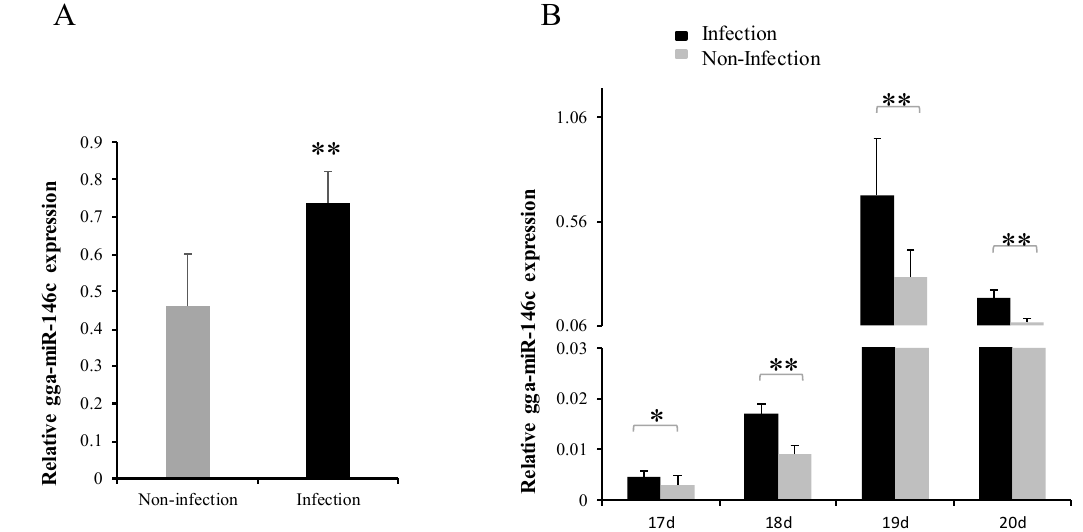
Figure 1. Mycoplasma gallisepticum ( MG) infection generated gga-miR-146c upregulation. Relative gga-miR-146c expression in MG noninfected or infected DF-1 cells ( A ) and in 17 days to 20 days (8 to 11 days post-infection) chicken embryo lung tissues ( B ). RT-qPCR was performed to assess gga-miR-146c expression that normalized to 5S-rRNA. Uninfected groups served as negative controls. Values are mean ± SD, * P < 0.05, ** P <